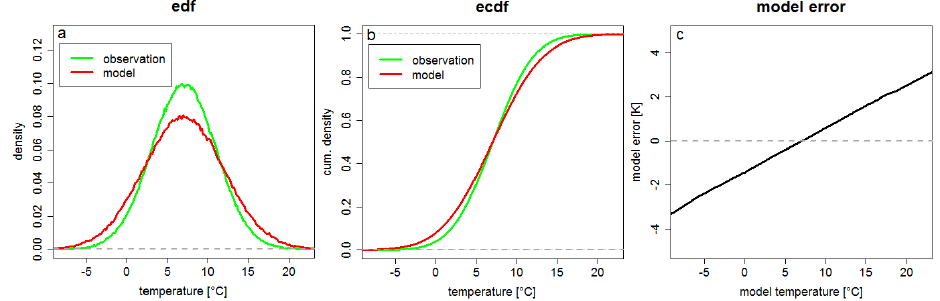
Figure 1. Intensity-dependent model errors of a model that overestimates daily temperature variability (artificial data). (a) Modeled (red, standard deviation of 5 ◦ C) and observed (green, standard deviation of 4 ◦ C) empirical density functions; (b) modeled (red) and observed (green) ECDFs; (c) model error at different modeled